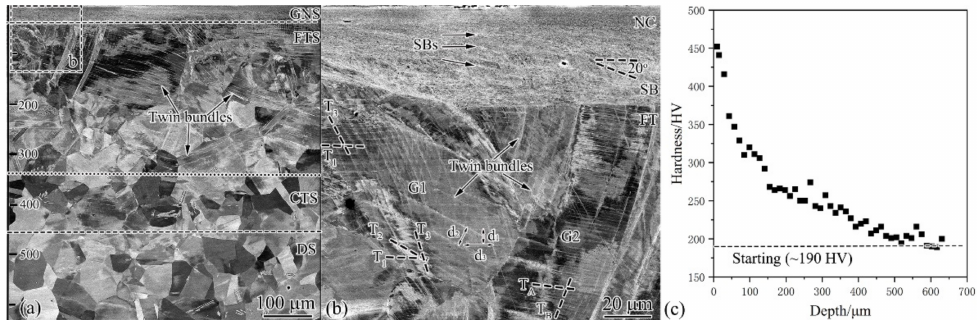
Figure 3. Cross-sectional SEM observations ( a ), the enlarged image of the rectangle area ( b ), and the variation of Vickers hardness as a function of depth ( c ) for the USRT AISI 304 stainless steel. Note that GNS was followed by SB (shear bands), FTS (fine-twinned structure), CTS (coarse-twinned structure), and DS (dislocation structure). Hardened layer of 600 µm thick was produced, with the maximum of 450 HV.